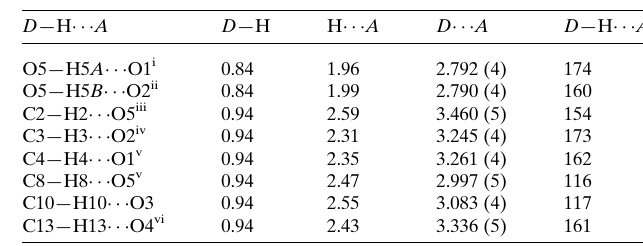
Table 1 Hydrogen-bond geometry (A˚ , (cid:3) ).